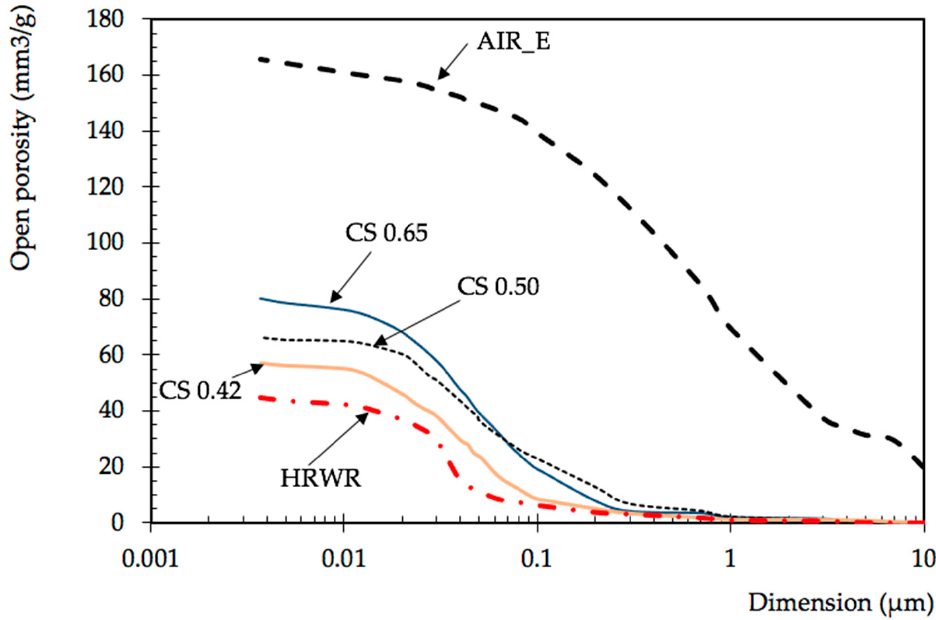
Figure 3. MIP porosity of mortars 1, 2A, and 3 cured at 7 days .